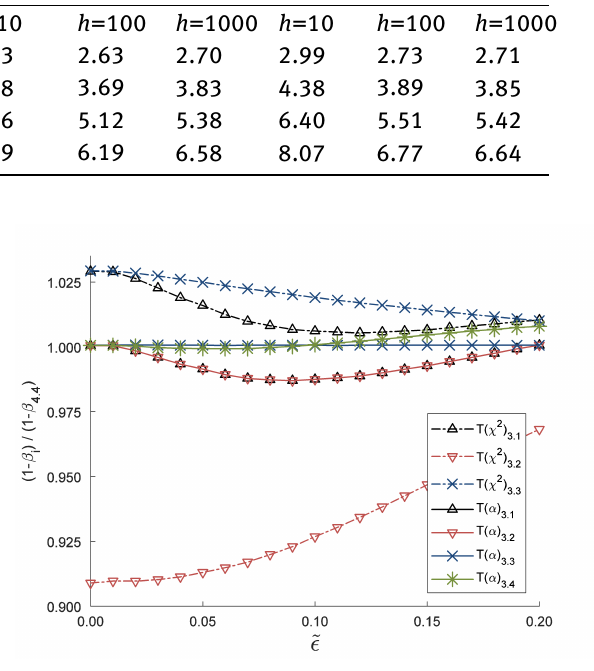
Figure 5: Power function ratios for h =100 (medium non-linearity). Dotted curves: using χ 2 (1) -quantiles and are denoted by T (︀ χ 2 )︀ , solid curves: using true quantiles for critical values and are denoted by T ( α ) . Black and red solid curves visually overlap.